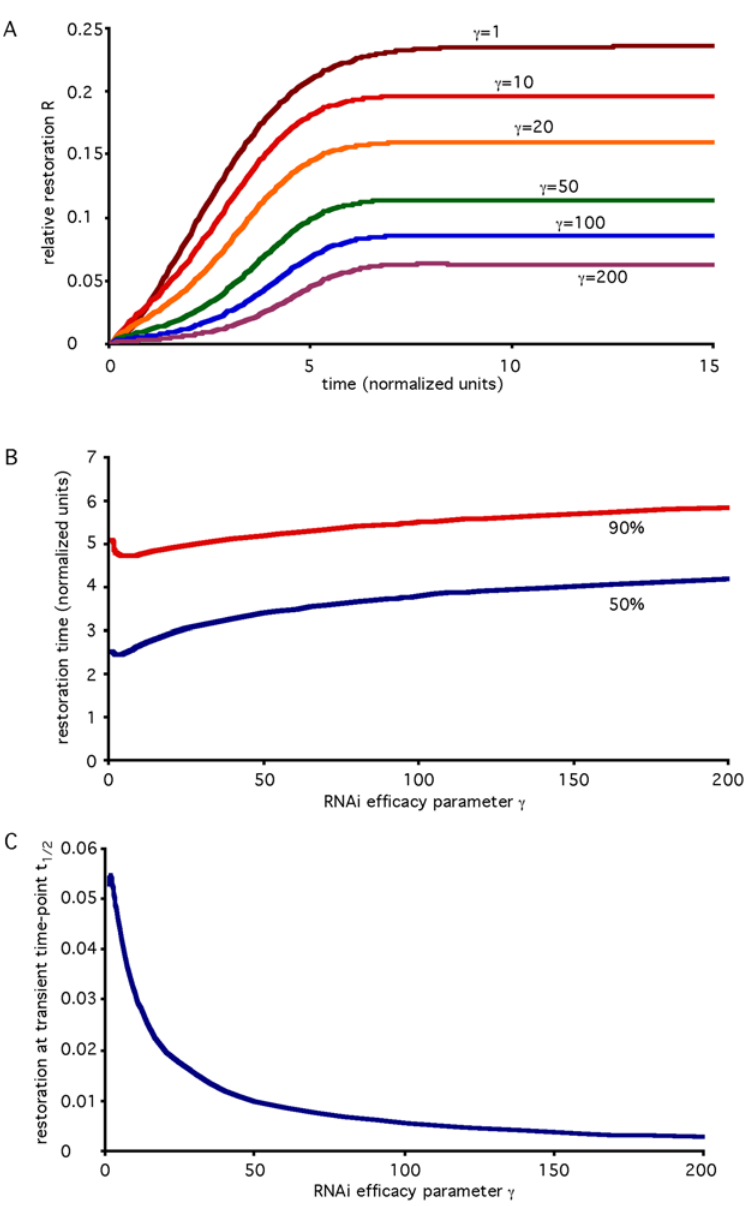
Figure5. TransientbehaviorofrecursiveRNAi. Restorationof reporterlevels duringrecursive RNAi ofDicer determinedbynumerical simulation. (A) Time-course of restoration of reporter gene level plotted as a function of time following recursive RNAi of Dicer, for different values of the RNAi efficacy parameter gamma. Curves show that even at transient time-points before reaching steady state, restoration is always higher for lower values of gamma. (B) Time required toreach50% (blue)or90%(red) offinalsteady-state restorationvalue,plotted versusRNAi efficacy parameter. (C) Restorationinreporter seen during recursive RNAi of Dicer at a specific time-point t1/2 defined as the time required for the same reporter gene to be knocked down to half its final level of knockdown in the absence of recursive RNAi. This curve provides a measure of the degree of restoration achieved at a standardized transient time-point, confirming that increasing values of gamma give decreasing restoration, even in the transient case. efficacy ( c ) have lower restoration. This is confirmed in Figure 5C, which plots restoration versus gamma at a specific transient time- point defined as the time at which GFP would be knocked down to 50% of its steady-state knockdown level following induction of RNAi. At this transient time-point, the restoration clearly decreases as gamma increases, mirroring the results plotted in Figure 4 for the steady-state behavior. These results indicate that the general conclusions reached about the detectability and effectiveness of recursive RNAi obtained by analytic determination of the steady-state solution also apply to the transient case. Figure 5A that at all time-points, systems with greater RNAi